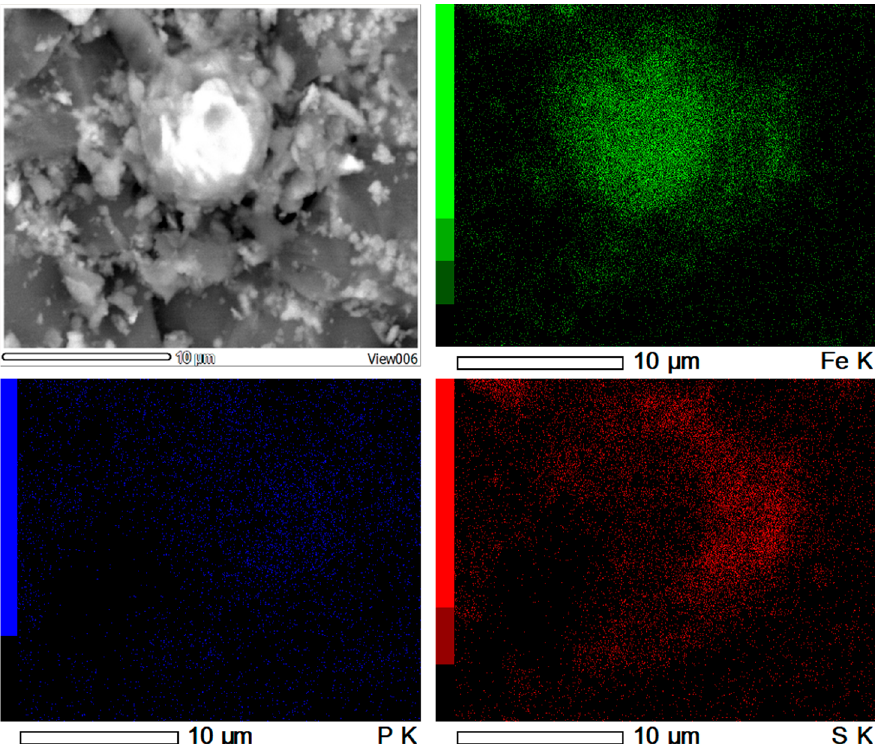
Figure 15. SEM image (BEC) of the roasted RM with the distribution of Fe, P and S at T = 1200 °C, t = 30 min, 13.65% Na 2 SO 4 .